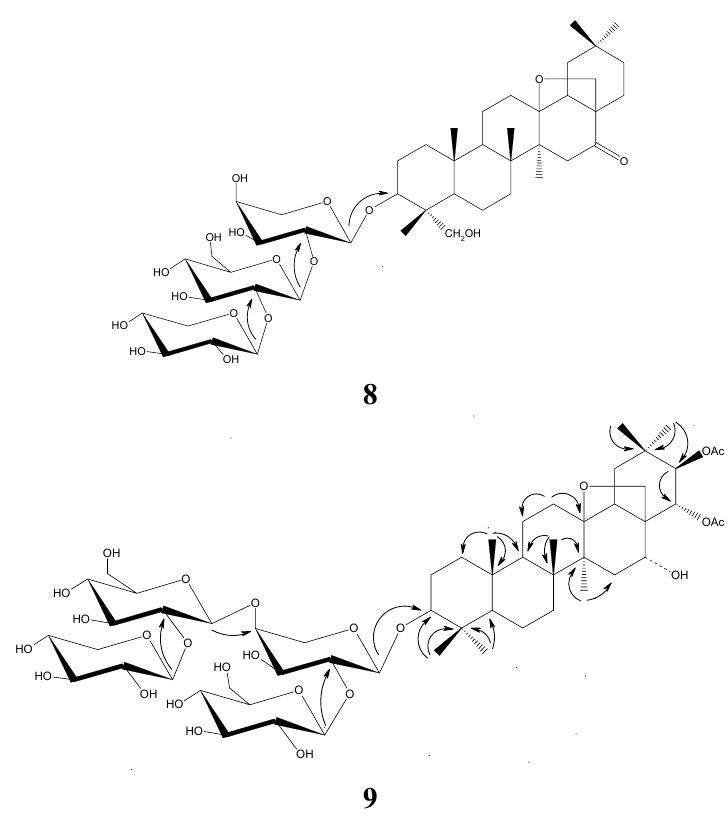
Figure 1. The structures and key correlations for compounds 8 and 9